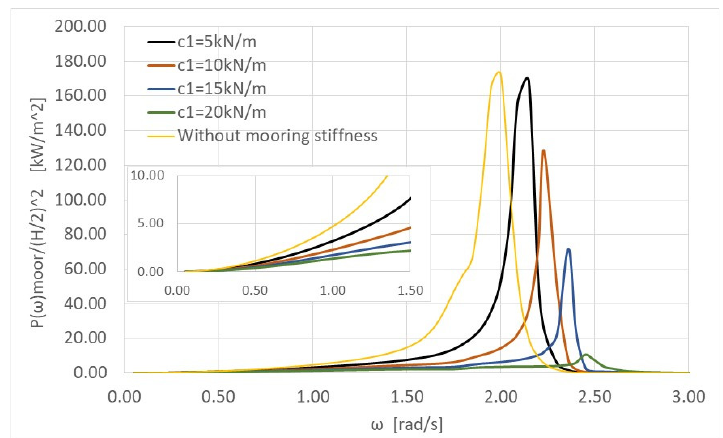
Figure 16. Total absorbed power by the WEC array for four different mooring stiffness values. Here the WECs are placed in a parallel to the wall direction, with inter-body spacing l mb = l b = 10D and distance from the wall L = D. The results are compared also with the total absorbed power by the WEC, without mooring stiffness.